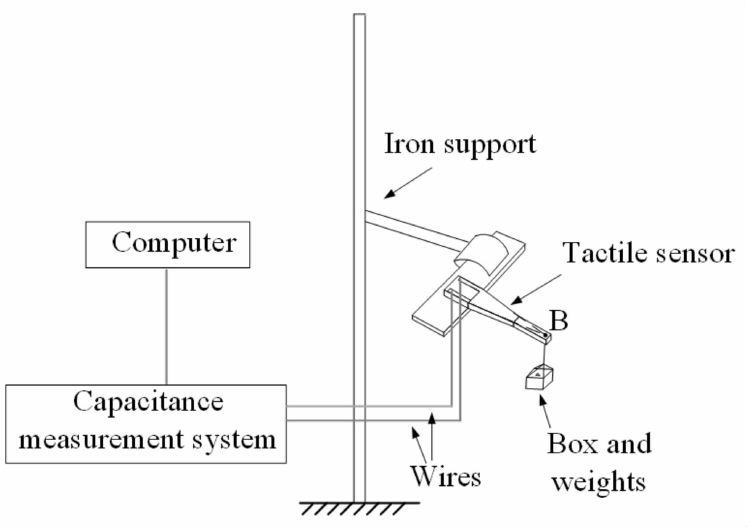
Figure 6. Schematic diagram of experimental setup for the force sensing